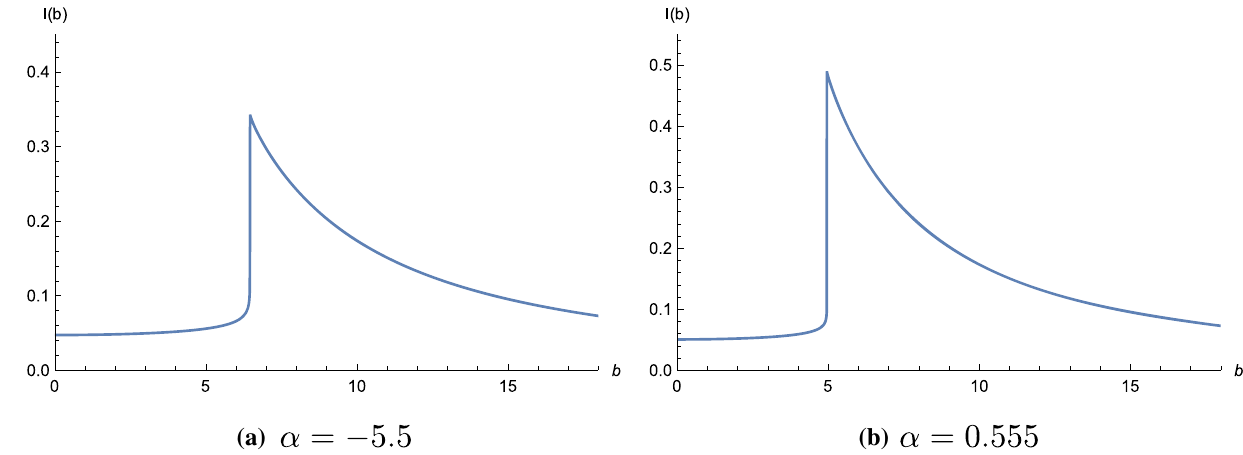
Fig. 5 The profiles of the specific intensity I ( b ) seen by a distant observer for an infalling accretion. For both cases, we set M = 1